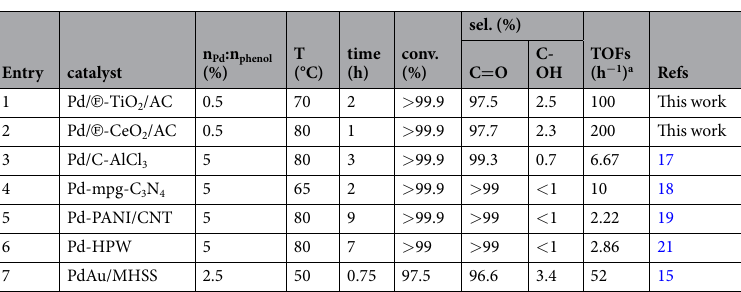
Table 3. Comparison of different catalysts for phenol hydrogenation. a TOFs = mole of product/(moles of Pd * reaction